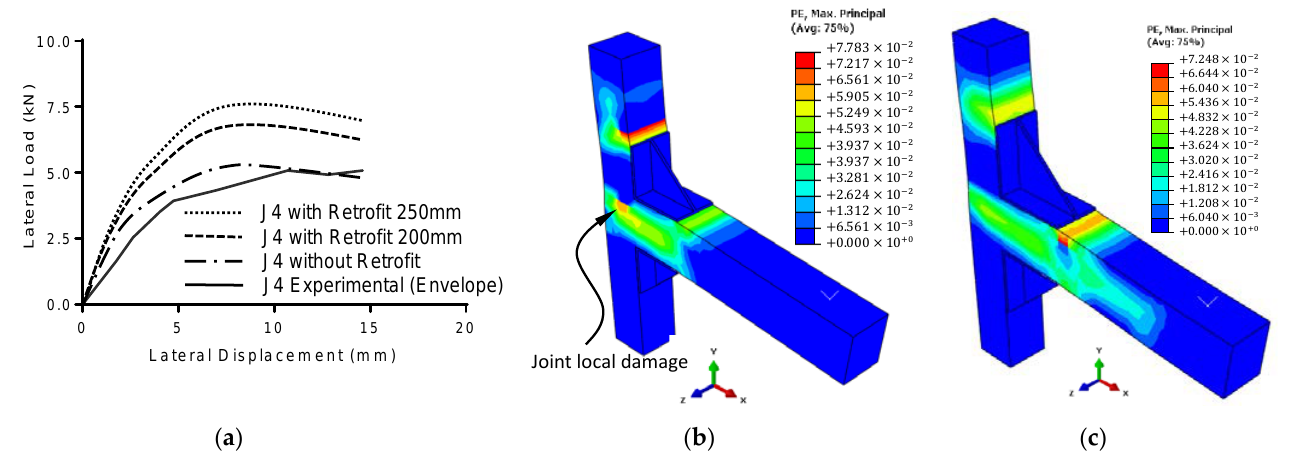
Figure 17. Ultimate resistance and damage of retrofitted joint J4. ( a ) Joint J4 with haunch. ( b ) Damage with 200 mm haunch. ( c ) Damage with 250 mm haunch.